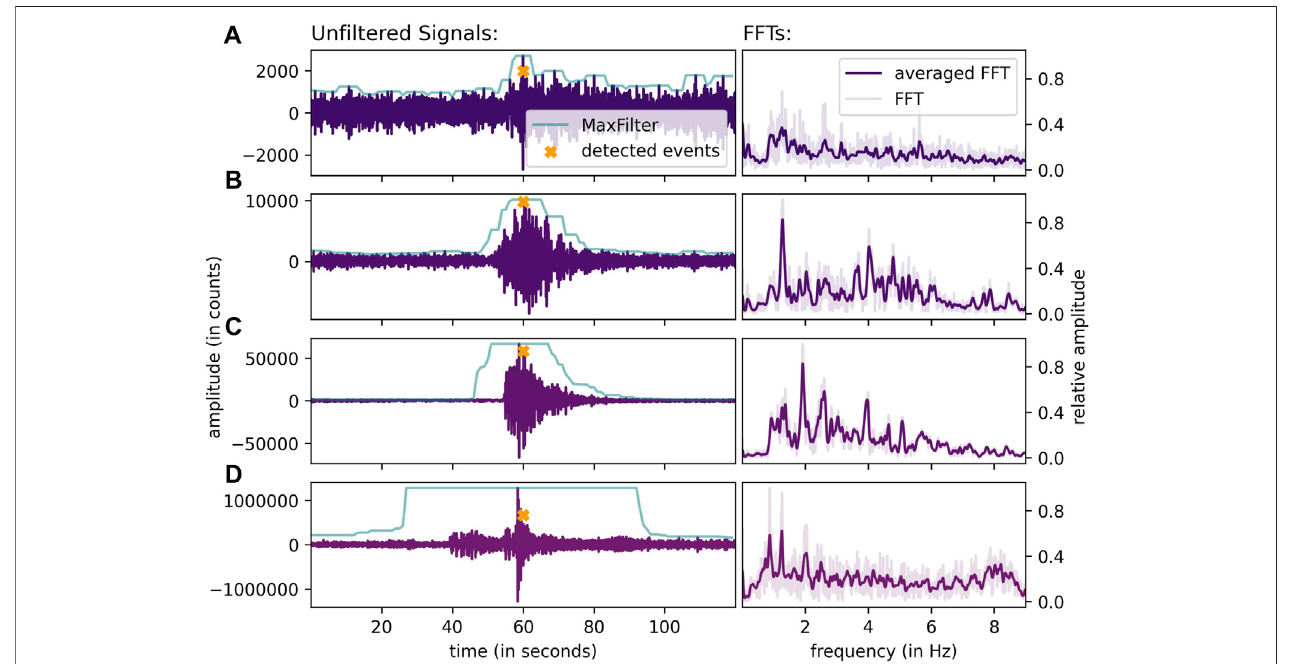
FIGURE 9 | Examples of recorded events with different amplitudes and their spectra (FFTs). The green line corresponds to the adaptive MaxFilter data. The slight discrepancybetweentheamplitude ofthesignal andthe detected event(markedbythe orangecross) isdueto fi ltering(discussedin section 2.2.2 ) (A) aminor eventof smallamplitude. (B) eventwithaverageamplitude. (C) aneventofamplitude60.000;onaverage,fewerthan5eventspermonthhaveahigheramplitudethanthisevent. (D) paroxysm at 3 June 2019 (the duration of the paroxysm is longer, but the identi fi ed time-window includes the highest measured amplitude).